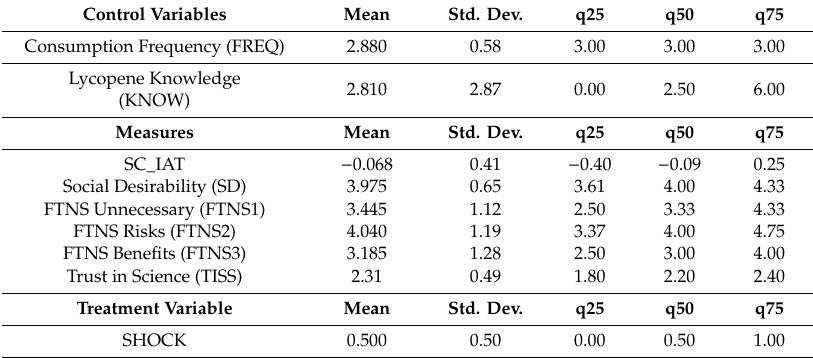
Table 2. Summary statistics of the Control variables and